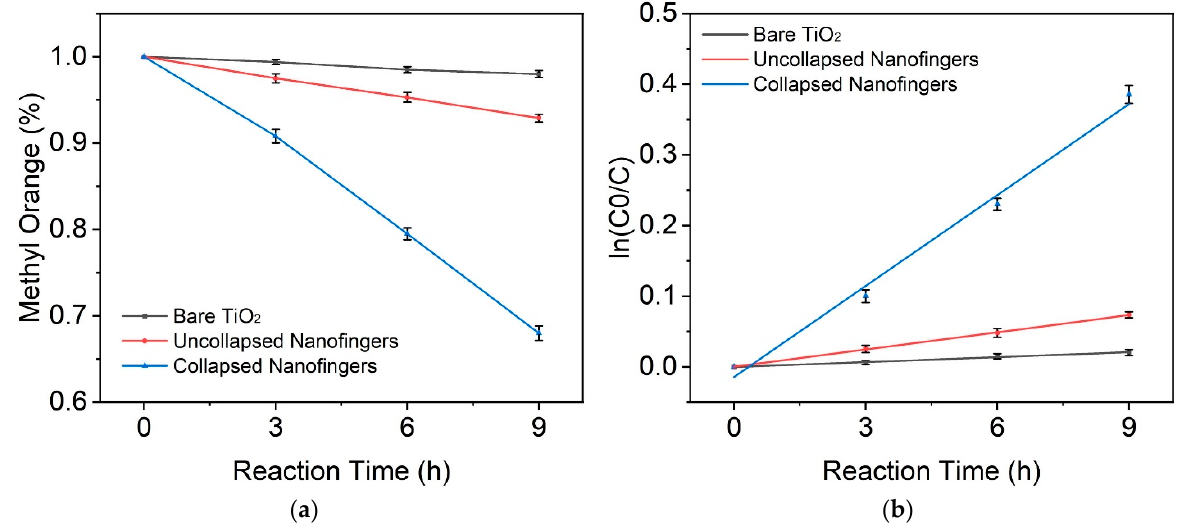
Figure 5. ( a ) Concentration of methyl orange dye at different reaction times. ( b ) Modeling of the photocatalytic kinetics of methyl orange according to the Langmuir–Hinshelwood model .